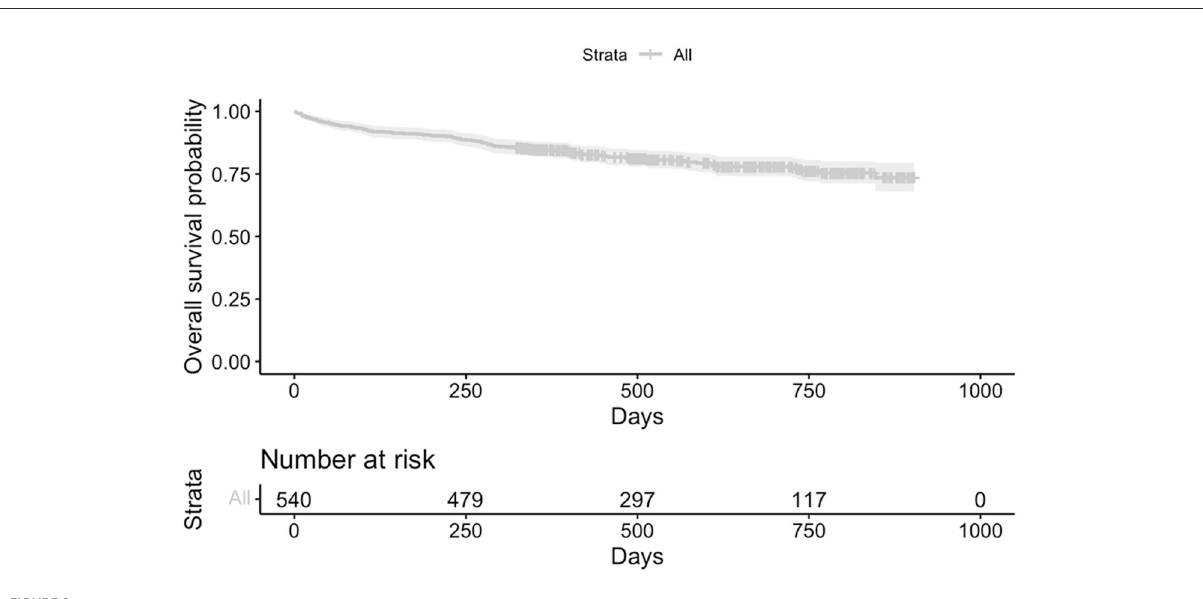
FIGURE2 Kaplan–Meier survival curve along the follow-up